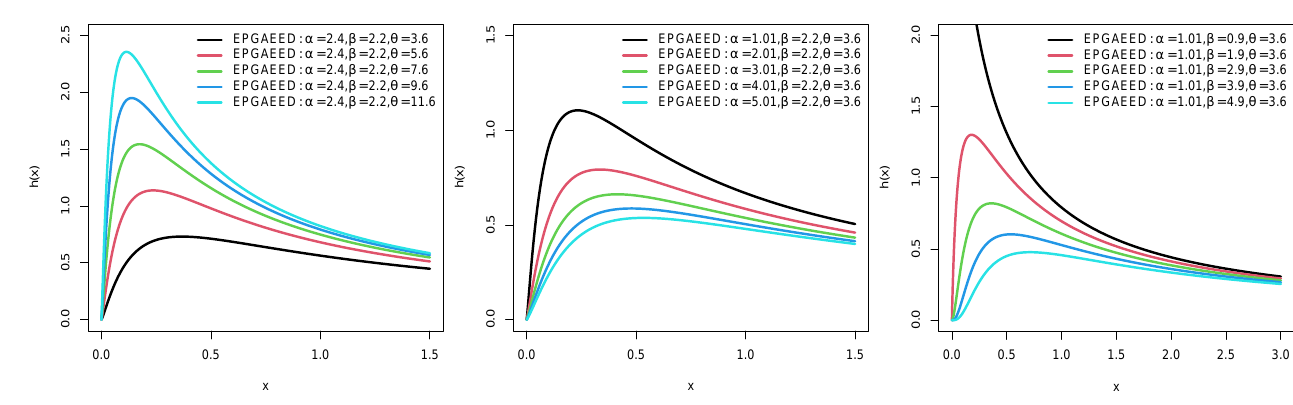
Figure 1. Plots of the pdf for the EPAIG-ED.